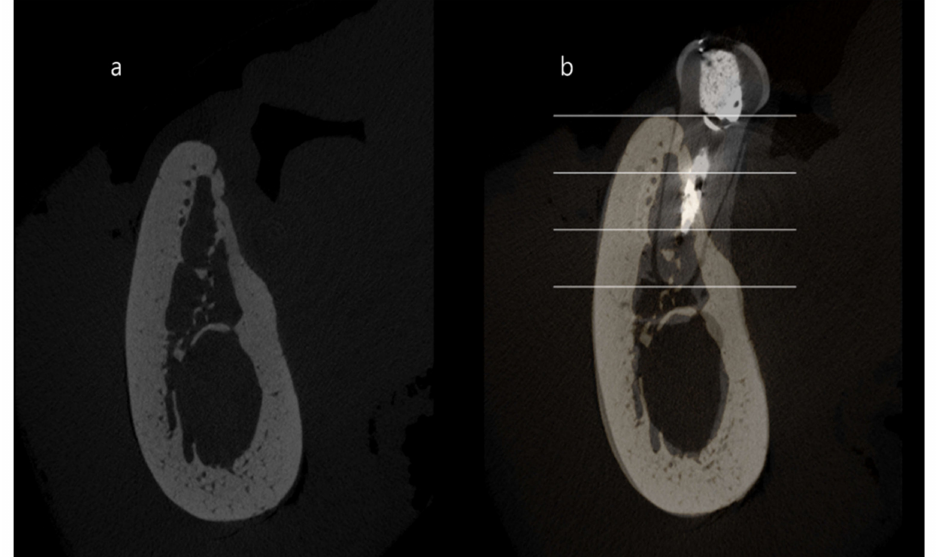
Figure 4. Buccolingual micro-computed tomography images. ( a ) extraction socket of mesial root area and ( b ) superimposition of extraction socket (mesial) area and distal root. The area was divided into three areas, with coronal, middle and apical